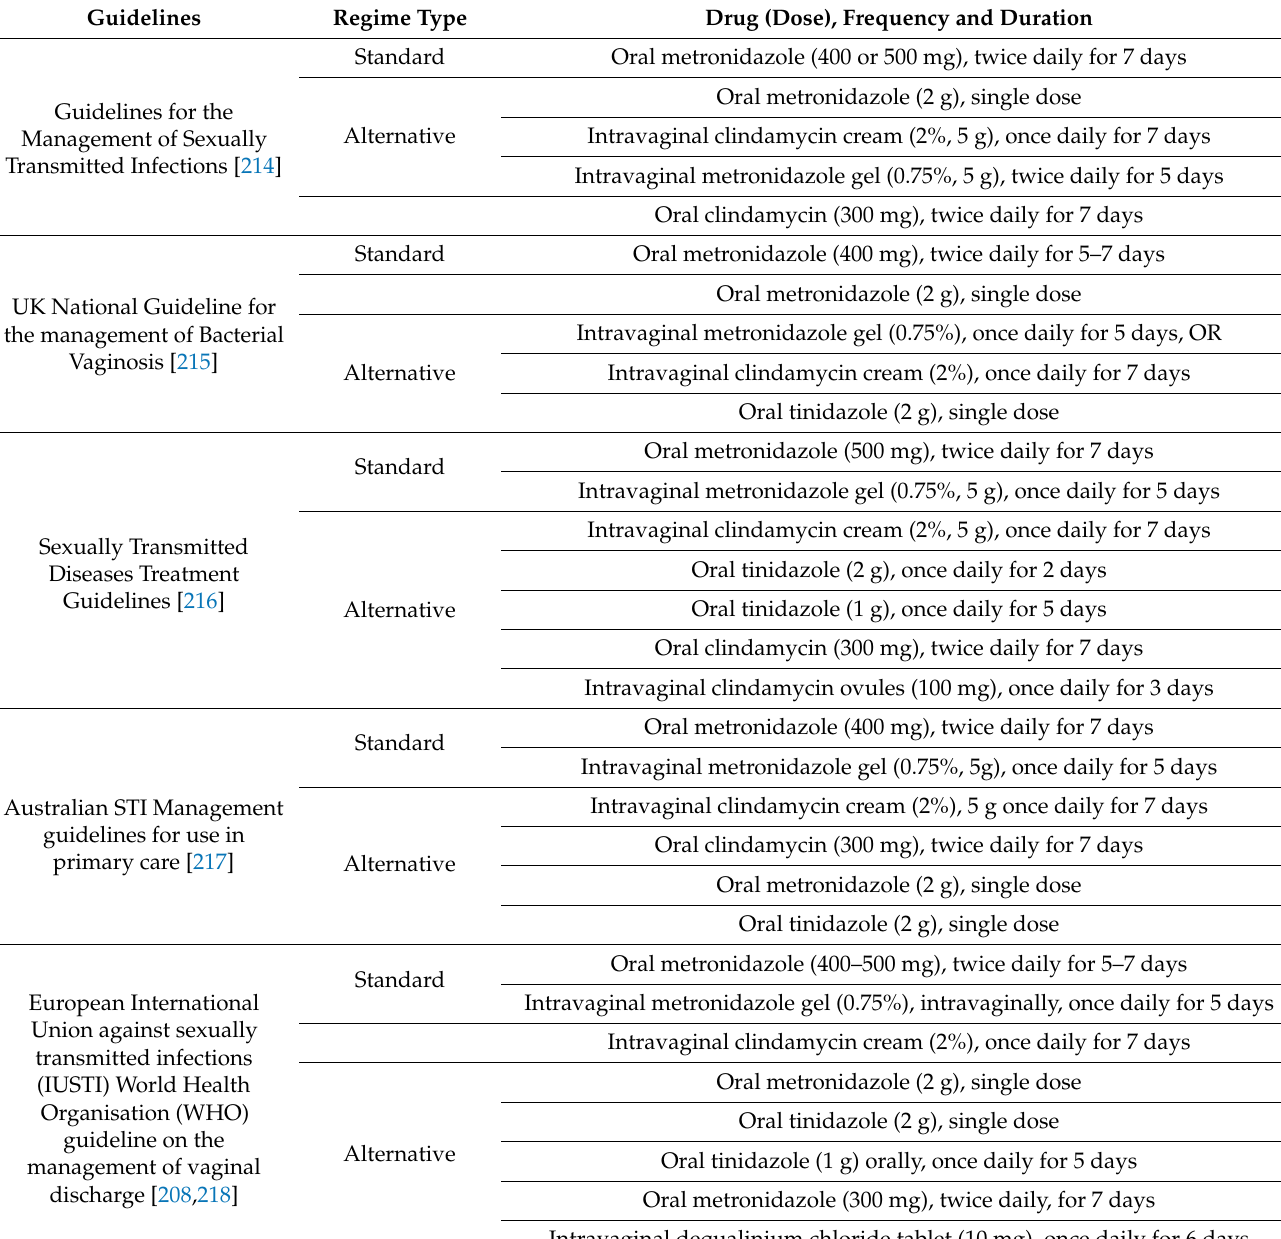
Table 3. Treatment guidelines for non-pregnant women with bacterial